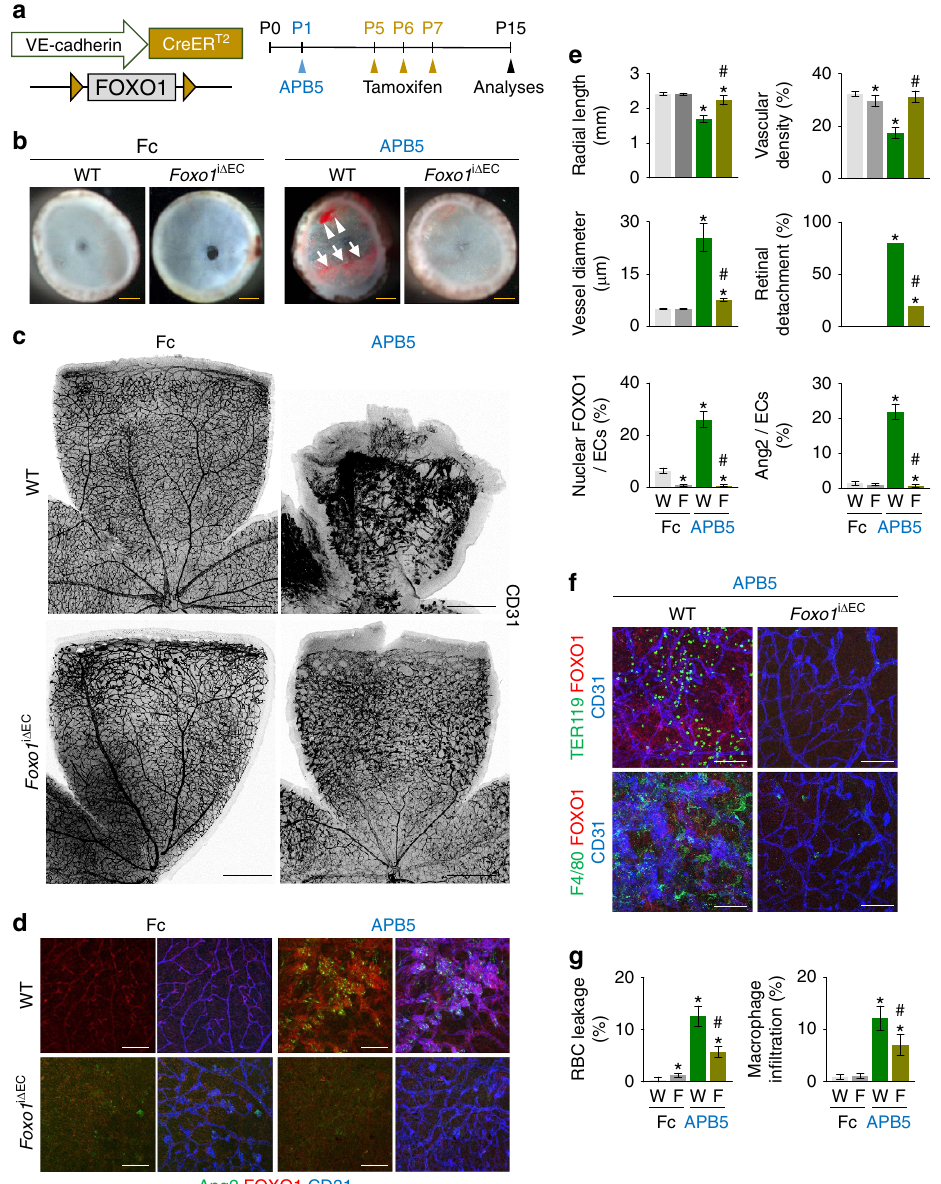
Figure 6 | FOXO1 inactivation attenuates BRB impairments caused by lack of pericytes. ( a ) Diagram depicting the experiment schedule for APB5 treatment at P1 and EC-specific depletion of FOXO1 ( Foxo1 i D EC ) from P5, and their analyses at P15. ( b ) Images of inner surface of retinal cup of WT and Foxo1 i D EC mice treated with either Fc of IgG (Fc) or APB5. Note that profound retinal hemorrhage (arrowheads) and retinal detachment (arrows) are detected in WTmice treated with APB5, but these phenotypes are largely attenuated in Foxo1 i D EC mice treated with APB5. ( c , d ) Images of CD31 þ retinal vessels, and expressions and localizations of Ang2 and FOXO1 in CD31 þ retinal vessels. Distinct retinal features such as disorganized and irregular enlarged vessels and less developed radial growth in WT mice treated with APB5 are largely ameliorated in Foxo1 i D EC mice treated with APB5. ( e ) Comparisons of indicated parameters in each group ( n ¼ 6). ( f , g ) Images and comparisons of TER119 þ RBC leakage and F4/80 þ macrophage infiltration in retinas of each group ( n ¼ 6). Error bars represent mean ± s.d. * P o 0.05 versus Fc-treated WT, # P o 0.05 versus APB5-treated WT by Kruskal–Wallis test. Scale bars, 100 m m (white) and 500 m m (yellow,